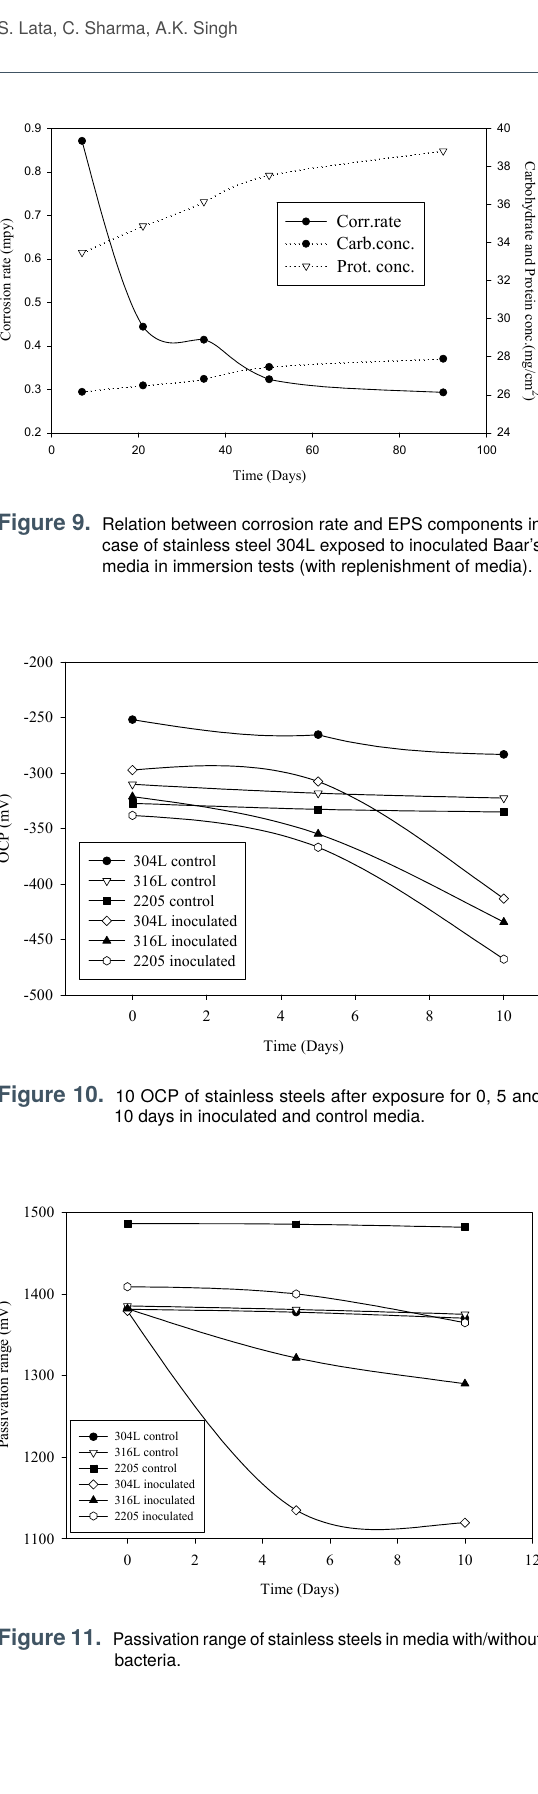
Fig. 14 Weight % of carbon, sulphur and phosphrous detected inside/outside pit formed on corroded stainless steel 304L